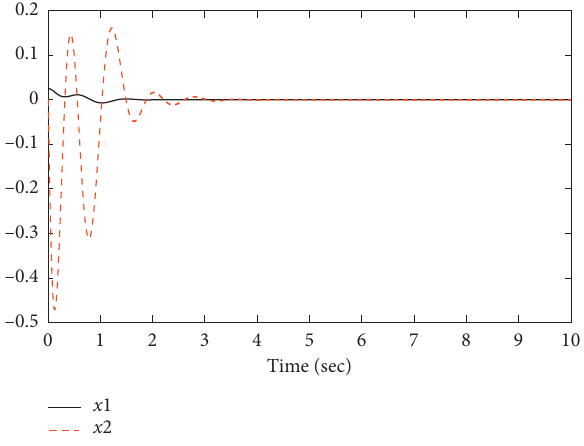
Figure 2: The trajectory of system